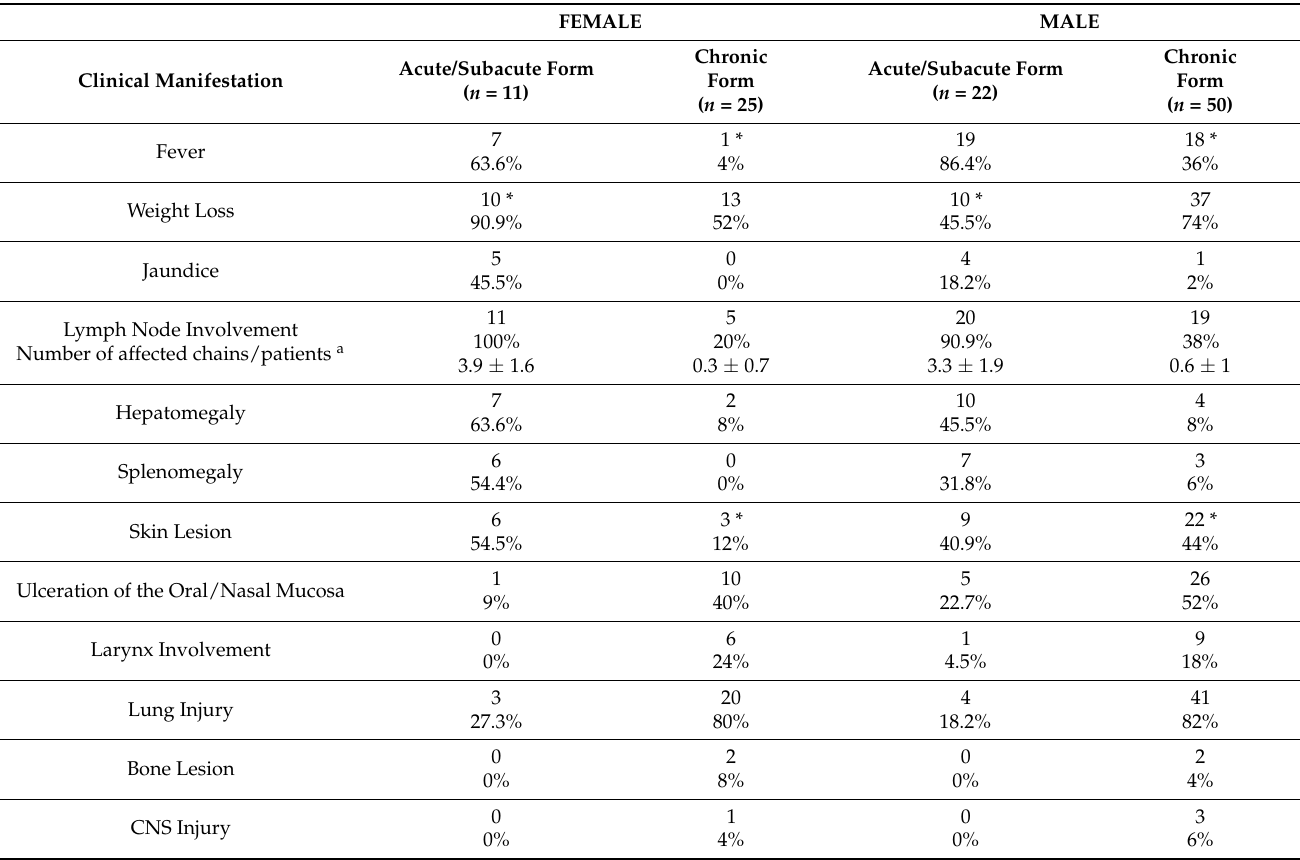
Table 2. Main clinical manifestations of women and men with